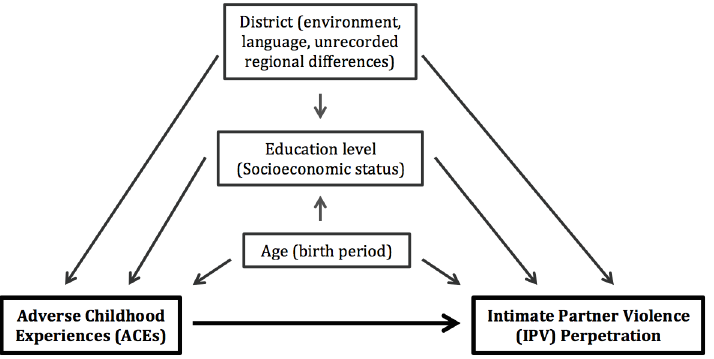
Fig 2. Directed acyclic graph (DAG) of the hypothesized relationship between ACEs and IPV with potential confounders, UN Multi-Country Study on Men and Violence in Asia and the Pacific, Sri Lanka, 2011 –